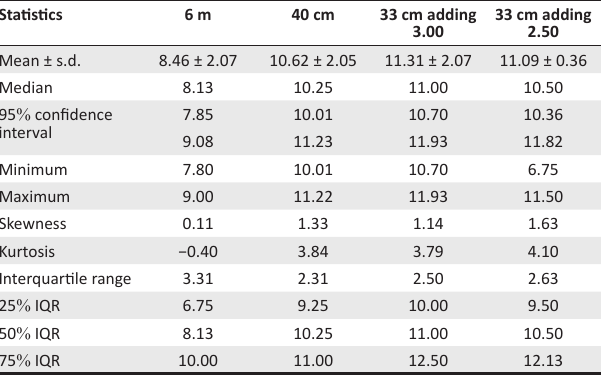
TABLE 2: Descriptive statistics of the means for the amplitude of accommodation using the minus-lens-to-blur method. Statistics 6 m 40 cm 33 cm adding